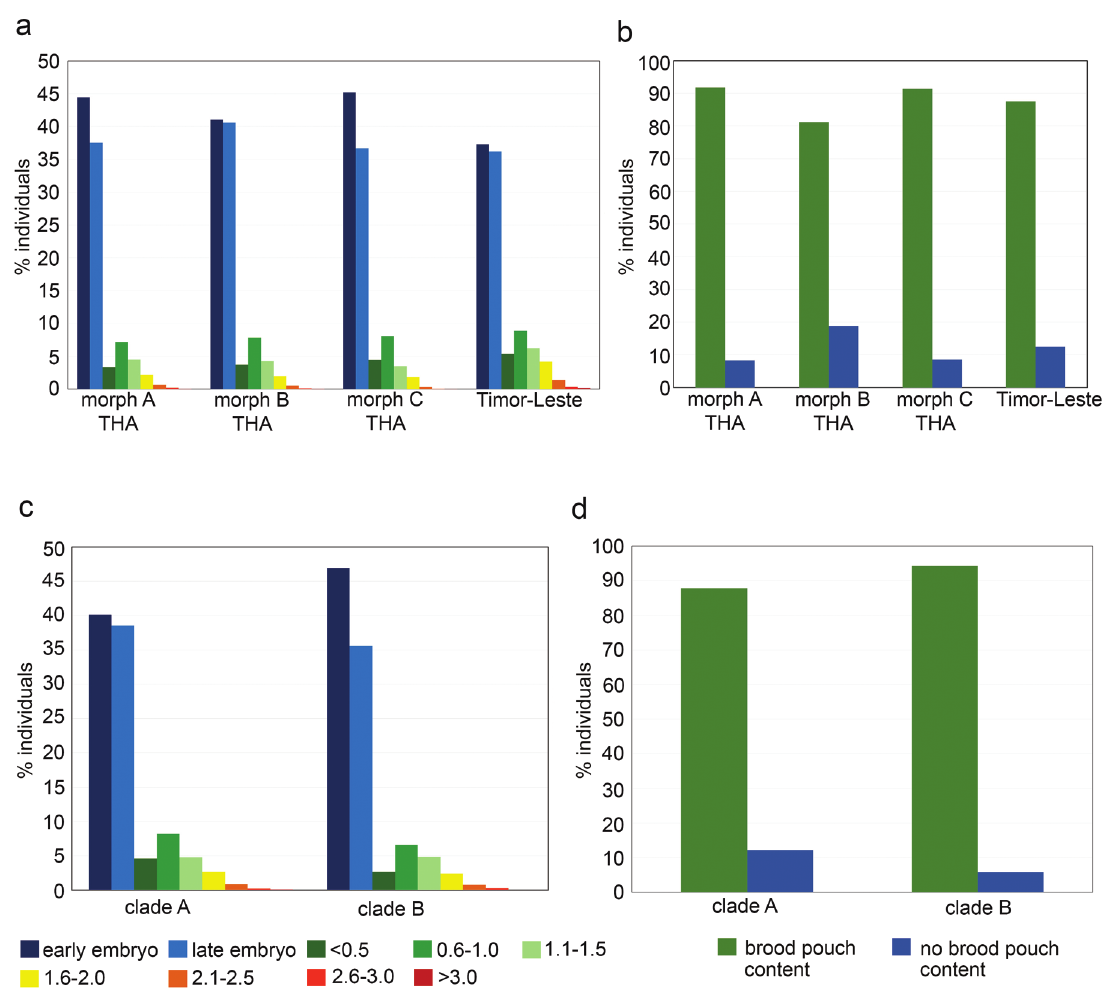
Figure 10. Composition of contents of the subhemocoelic brood pouches of female Tarebia granifera (Lamarck, 1816) ( a, c ) and proportions of gravid animals, i.e. those with filled brood pouch, versus non-gravid specimens ( b, d ) from Thailand and Timor Leste. a . Composition of contents of the brood pouches for morph A, B and C from Thailand (THA) and specimens from Timor Leste (see Figs 1, 8 and 9). b . Proportion of gravid vs. non-gravid specimens for morph A, B and C from Thailand and specimens from Timor Leste. c . Composition of contents of the brood pouches for mitochondrial clades A and B, respectively (see also Figs 4, 8, 9). d . Pro- portion of gravid vs. non-gravid specimens for mitochondrial clades A and B, respectively. For colour coding, see the inset